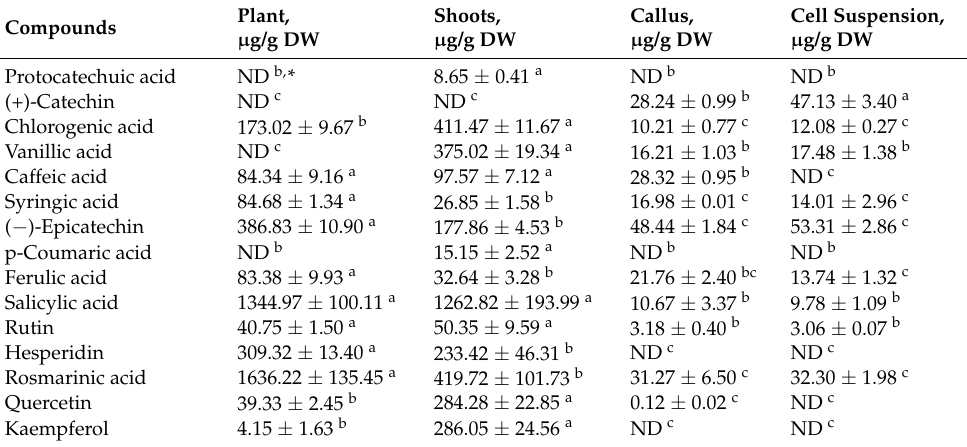
Table 1. HPLC analyses of phenolics found in G. jasminoides plant leaves, in vitro shoot, callus, and cell suspension cultures. Compounds